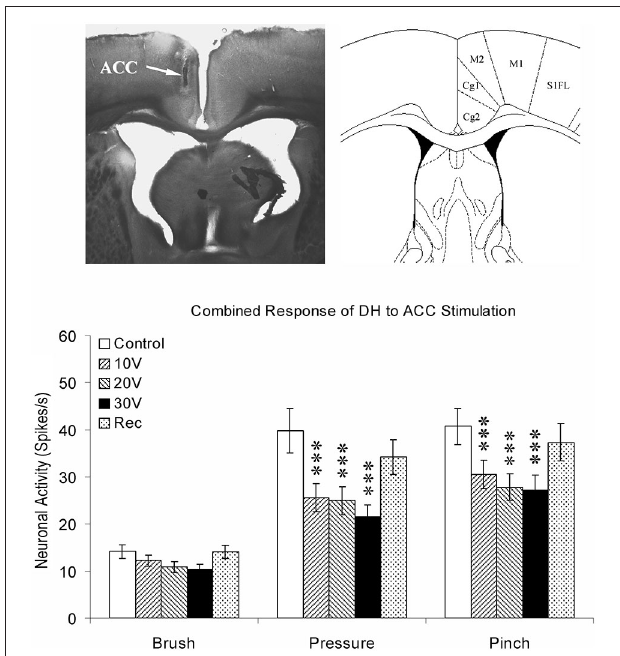
FIGURE 3 | Summary of ACC modulation of spinal dorsal horn neuronal responses . The site of stimulating electrode was verified by brain histology. The arrow points to the anterior cingulate cortex (Cg1) on the left according to the coordinates provided by Paxinos and Watson (1998) on the right. Responses of spinal dorsal horn (DH) neurons to mechanical stimuli (Brush, Pressure, and Pinch) during ACC stimulation. The results are combined for ipsilateral and contralateral ACC stimulation. *** p < 0.001 (Modified from Senapati et al., 2005, with permission).